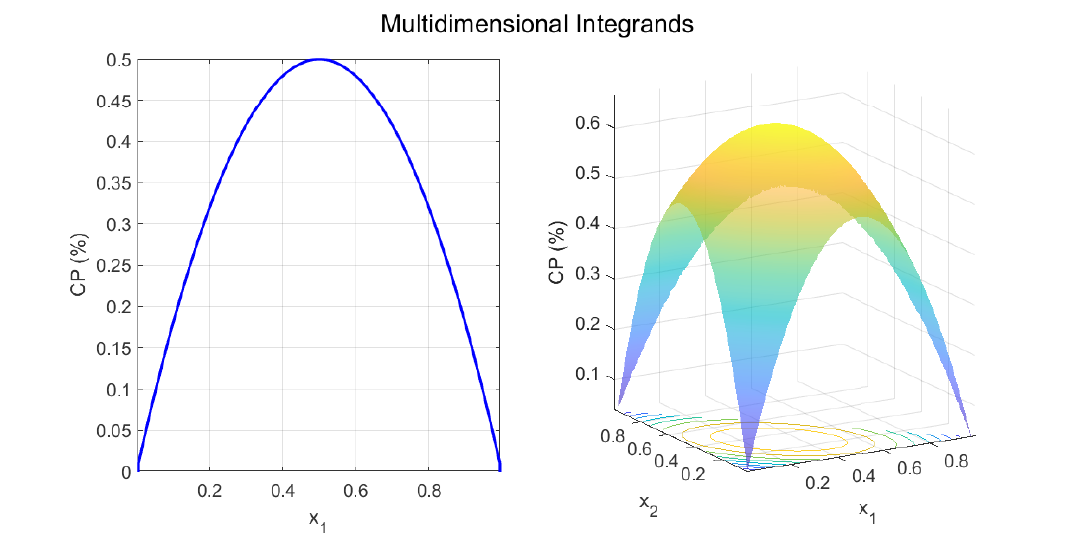
Figure 1. Integrands for D = 1 and D =